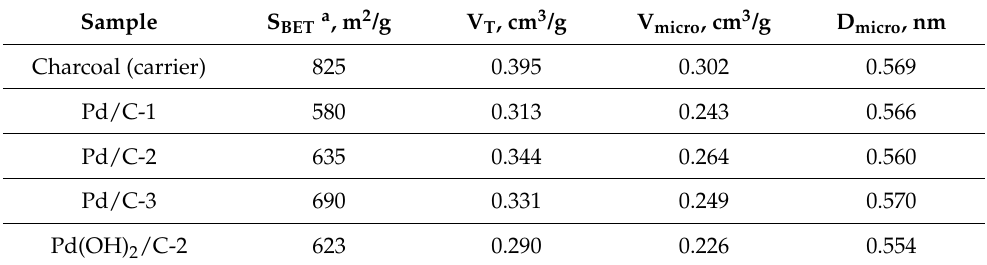
Table 1. Surface area and pore volume of the composites and starting carrier calculated from N 2 adsorption at 77 K. Sample S BET a , m 2 /g V T , cm 3 /g V micro , cm 3